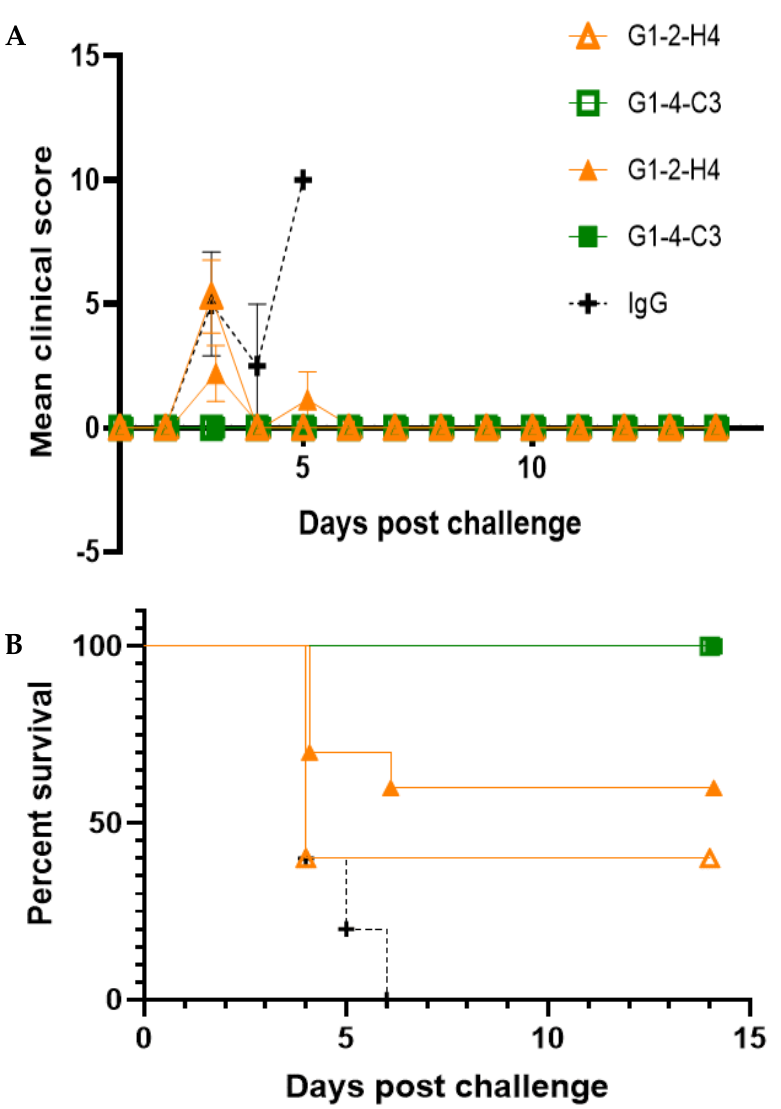
Figure 4. Evaluation of anti-EEEV NAb efficacy in a pre-exposure prophylaxis setting. Mean clinical score ( A ) and mortality rate ( B ) of BALB/c mice inoculated with candidate anti-EEEV NAbs at a dose of 2.5 mg/kg (empty symbols) or 10 mg/kg (filled symbols) via the IP route 24 h prior to a lethal exposure of EEEV PE6 via the aerosol route. Any deceased mice were assigned the maximum score observed in this study ( n = 10, except for the non-specific IgG control group, where n = 5). Error bars indicate the standard error of the mean.